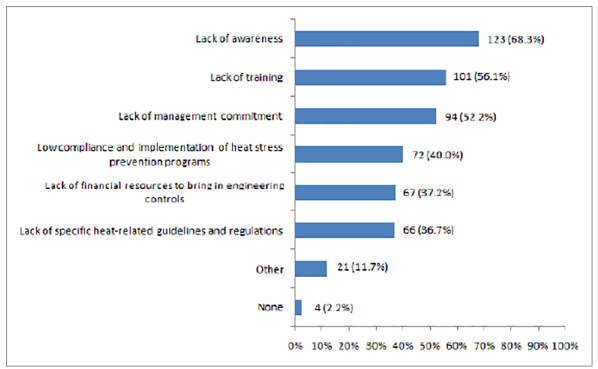
Fig 2. Heat prevention and adaptation barriers existing in the